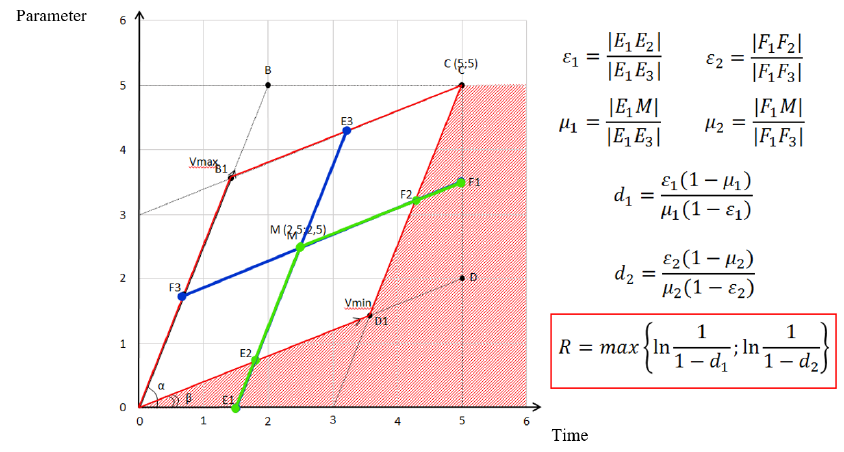
Figure 1. Main calculated ratios of Russman